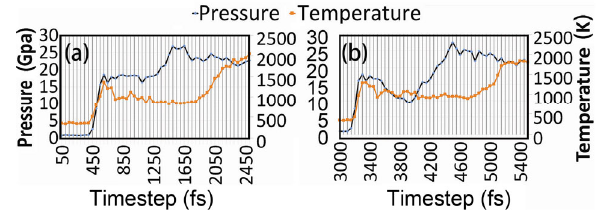
Fig. 7 The maximum pressure variation curve of the impact zone of the silicon substrate: (a) Pos20; (b) Pos150.